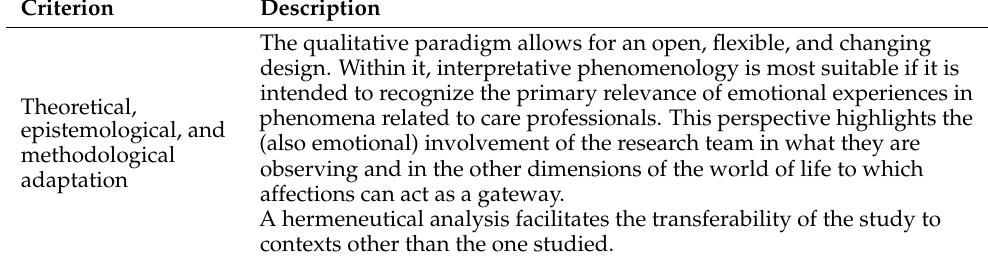
Table 2. Criteria of rigor and quality. NCM: nurse case